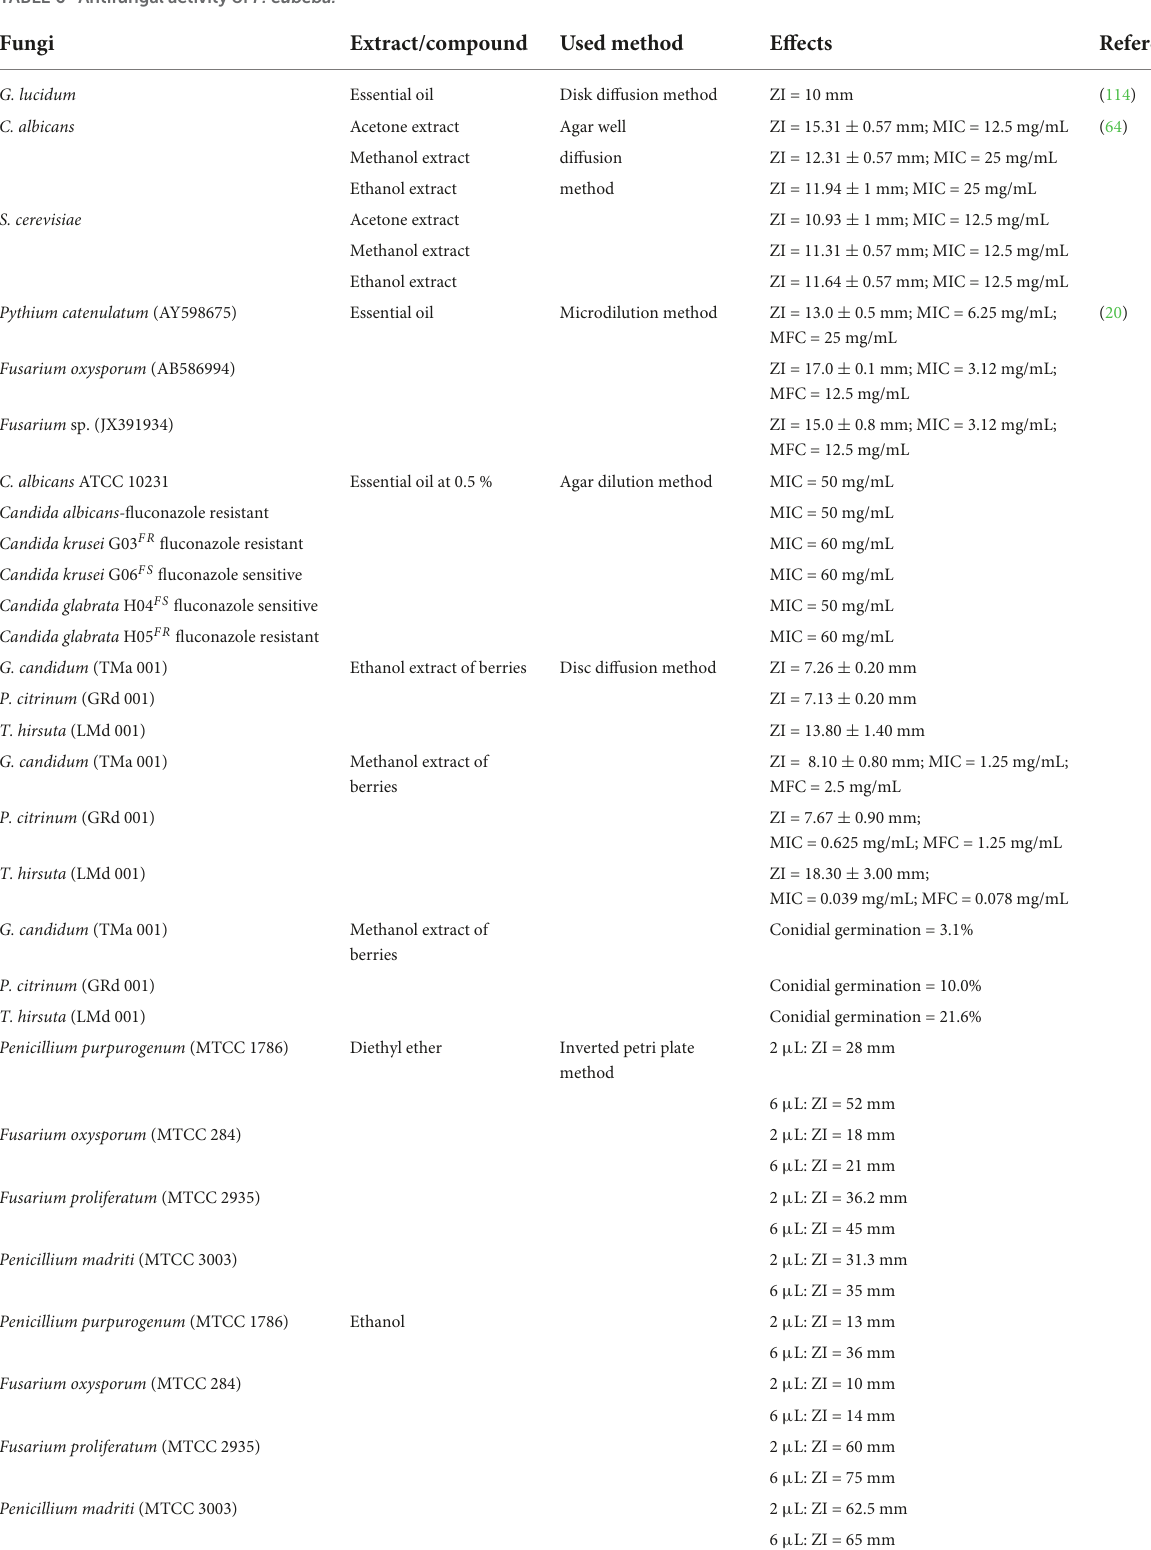
TABLE 6 Antifungal activity of P.